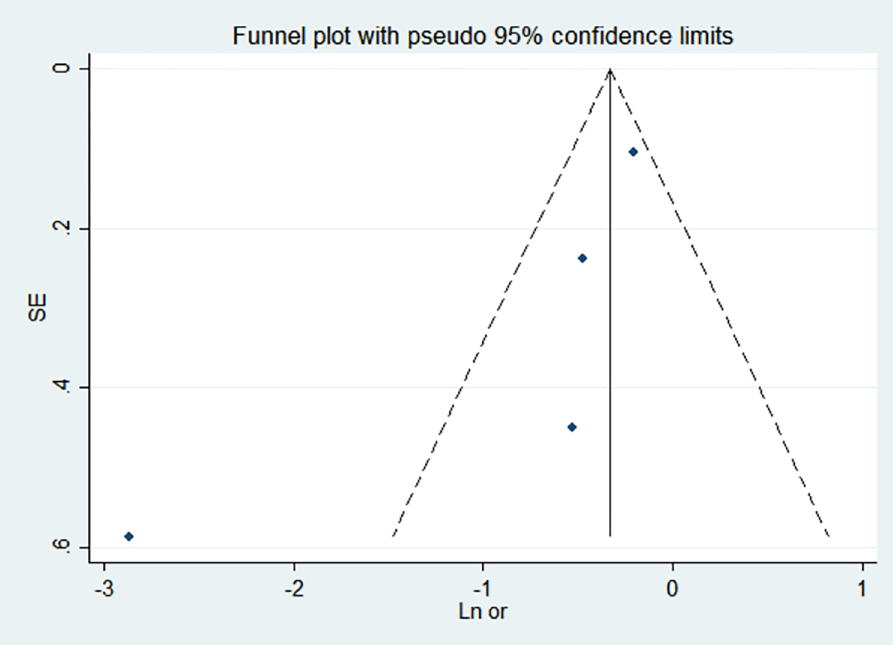
Fig 10. Funnel chart of birth weight.